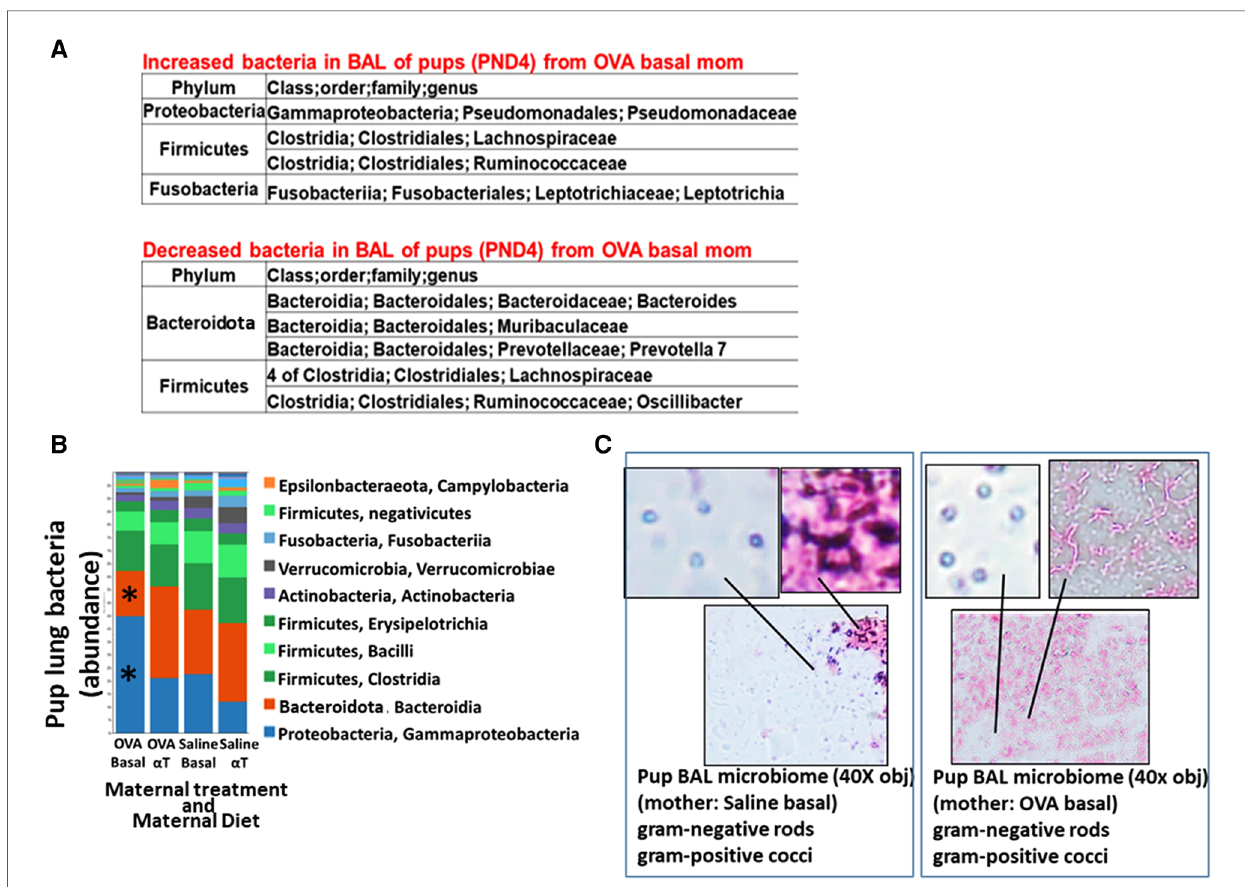
FIGURE 2 Pups of allergic mothers have altered lung bacteria microbial composition. Mouse treatments were as in ( Figure 1A ). BAL microbiota from pups at ( A ) PND4 and ( B,C ) 24 h after OVA-challenge (PND16) was separated and analyzed by 16S rRNA gene sequencing and a microbiome analysis pipeline. ( A ) At PND4, before allergen exposure, there was increased Proteobacteria and decreased Bacteroidota in the lungs of offspring of allergic mothers (log2FC>0.6, FDR<0.1) as compared to offspring of non-allergic mothers with basal diet. ( B ) ASV table of the relative abundance of phyla within the total pup BAL bacterial microbiome. * p <0.05 compared to other groups. ( C ) BAL microbiota from pup BAL PND16 were separated and concentrated by differential centrifugation as in the methods, suspended in minimal volume for fi xation in a small spot on a glass slide and stained with gram stain from bacteria. Representative images of lung microbiota are